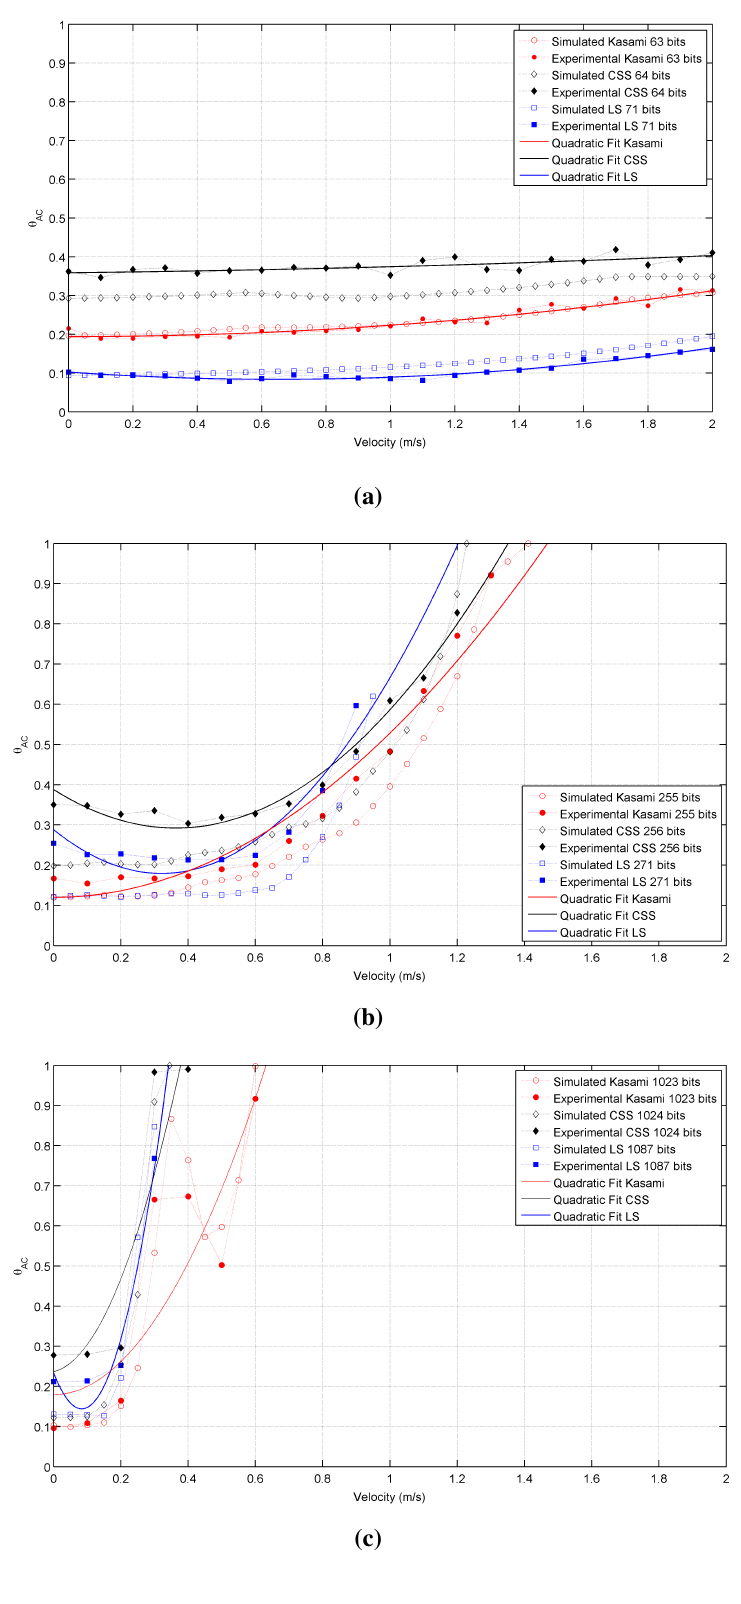
Figure 9. Simulated and experimental auto-correlation bounds for the sequences